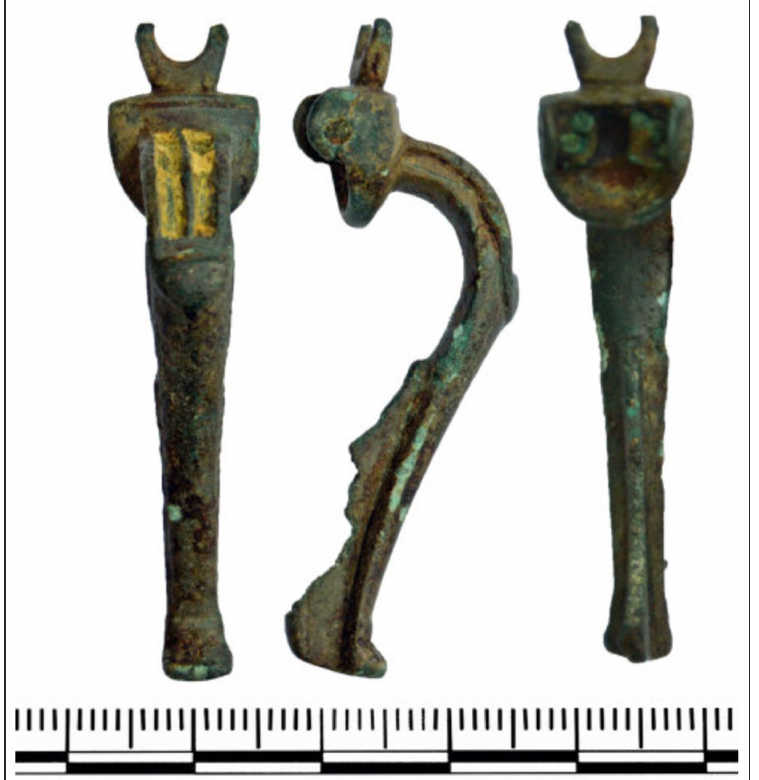
Figure 5: Copper alloy Wirral type brooch (Image of curtsey of the Portable Antiquities Scheme, Record ID: